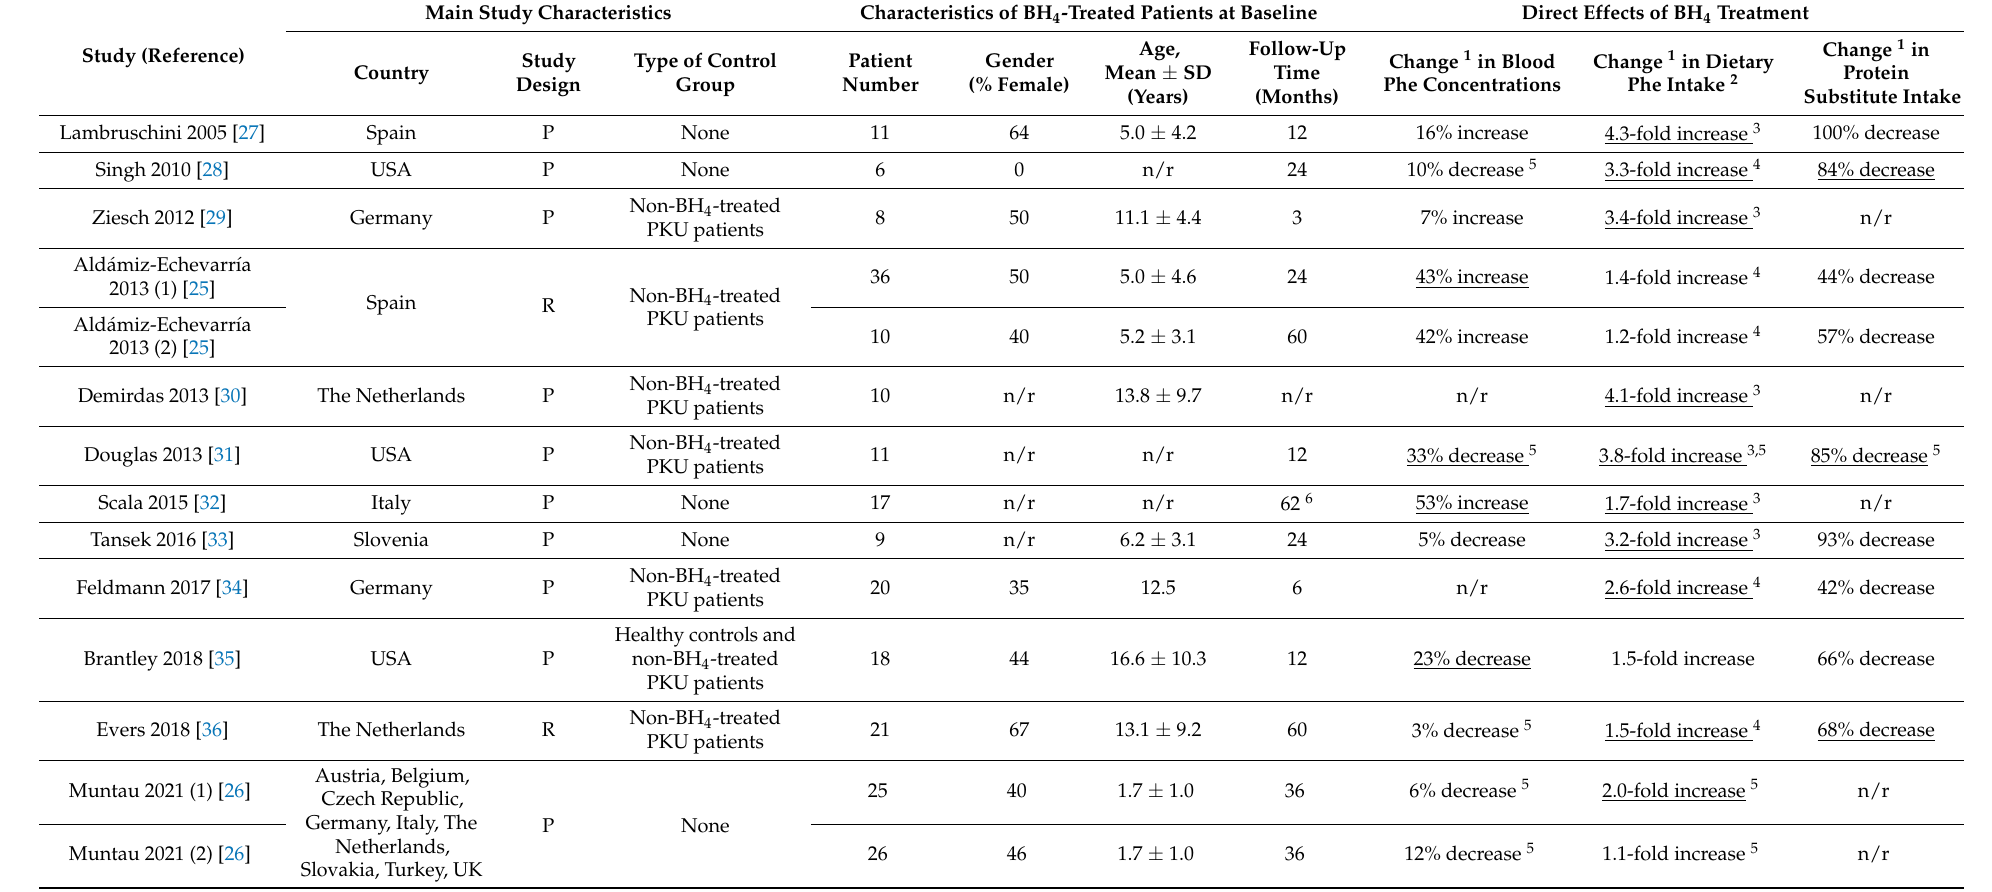
Table 2. 1 Last available moment of follow-up was used. 2 Or natural protein intake. 3 Body weight not taken into account. 4 Body weight taken into account. 5 Numbers not reported in manuscript; read from graph/figure. 6 Mean follow-up time (different follow-up times for different patients). Underlined results denote significant changes within the group of BH 4 -treated patients; if not underlined, there was either no significant change, or statistical analysis was not performed or reported. N/r, not reported. P, prospective. R,